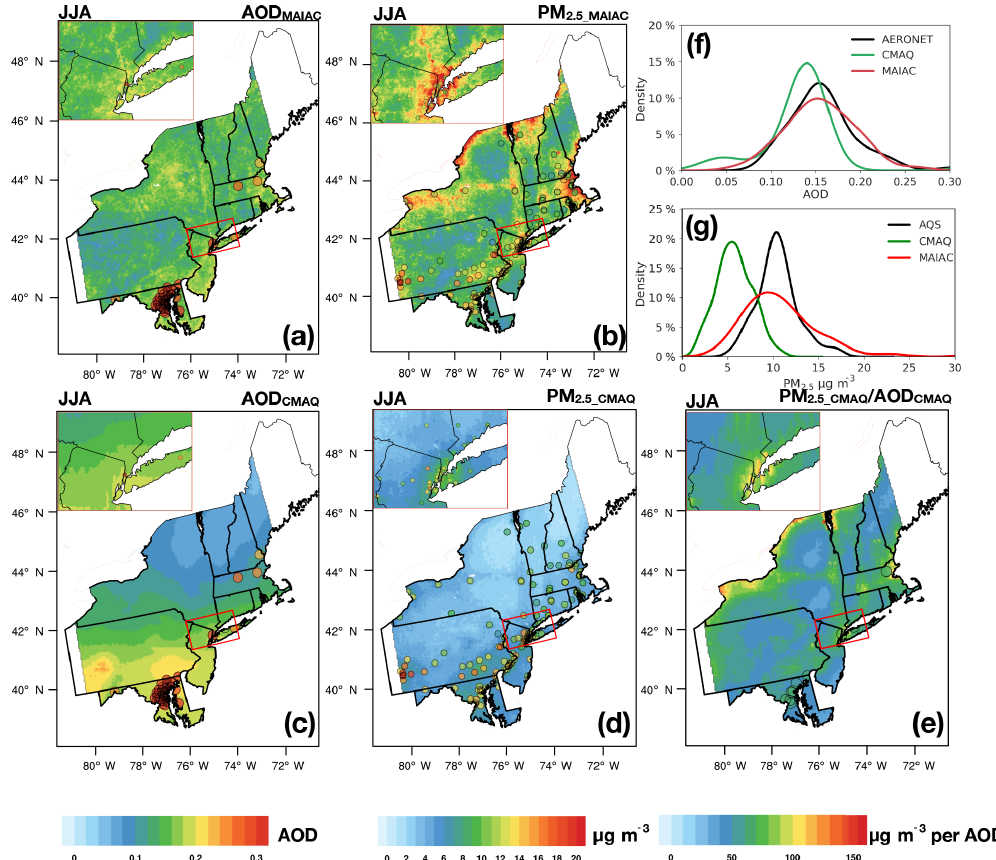
Figure 1. Summertime (JJA) average (a) MAIAC AOD (AOD MAIAC ), (b) satellite-derived PM 2 . 5 (PM 2 . 5_MAIAC ), (c) CMAQ model AOD (AOD CMAQ ), (d) CMAQ model PM 2 . 5 (PM 2 . 5_CMAQ ), and (e) CMAQ modeled PM 2 . 5 / AOD (PM 2 . 5_CMAQ / AOD CMAQ ) ratio overlaid with ground-based observations (AERONET, AQS, co-located AERONET and AQS sites) over the northeastern US with zoom-in maps over the New York City region in the upper left corner. (f) Density plot of AOD showing the distribution of MAIAC, CMAQ, and AERONET observed AOD sampled at AERONET sites. (g) Density plot of PM 2 . 5 showing the distribution of satellite-derived, CMAQ, and AQS observed PM 2 . 5 sampled at AQS